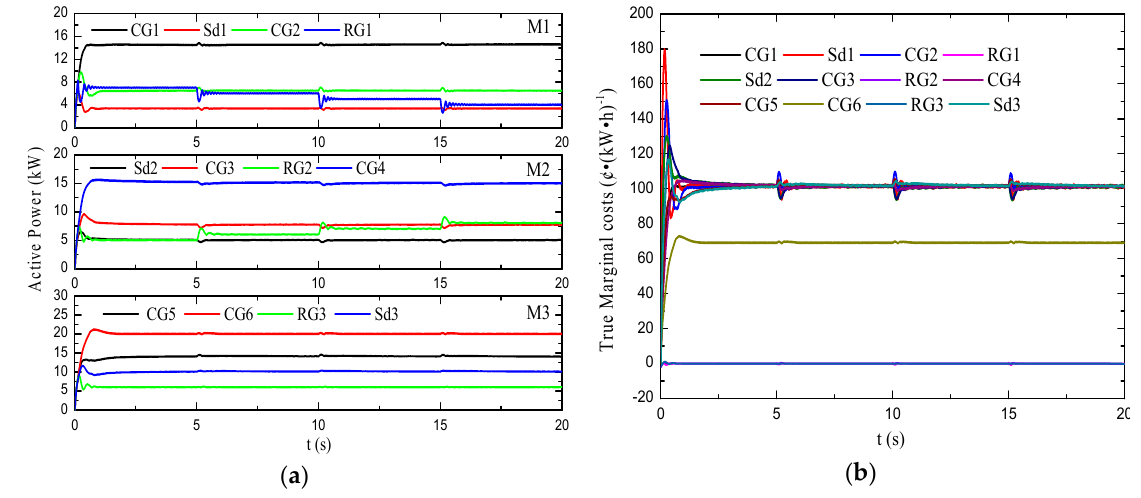
Figure 6. The operating characteristics with varying maximum powers of RGs: ( a ) Active power outputs of DERs; ( b ) The true marginal costs of DERs.